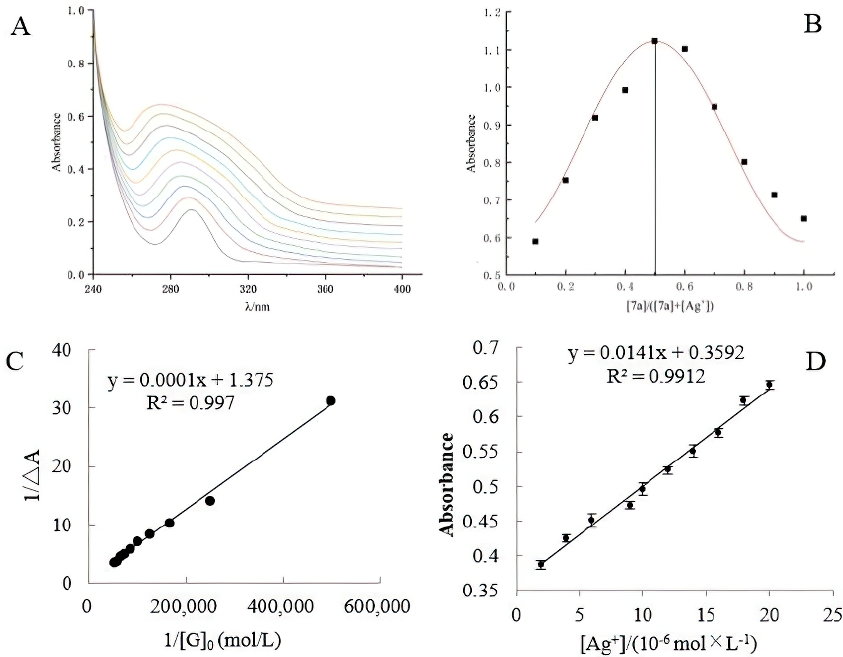
Figure 3. ( A ) UV-Vis spectra of the compound 7a (1.0 × 10 − 4 mol/L) in the presence of different concentrations of Ag + (0–20 μ mol/L). ( B ) Job’s plot for the inclusion complex of host compound 7a with Ag + . ( C ) Typical plot of 1/[G] 0 versus 1/ Δ A of the complex formed by the host compound 7a and Ag + . ( D ) The linear plot of absorbance against the concentration of Ag + (2–20 μ mol/L). Table 3. Comparison of various recognition sensors for Ag + . Compound Ref.